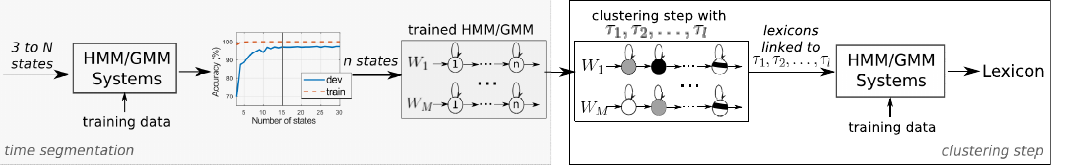
Figure 1. Illustration of the subword unit-based lexicon